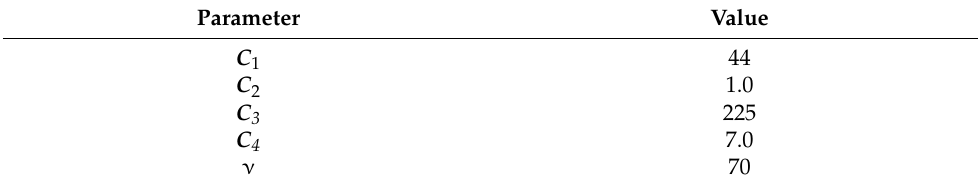
Table 2. The identified MR damper unit parameters [41].